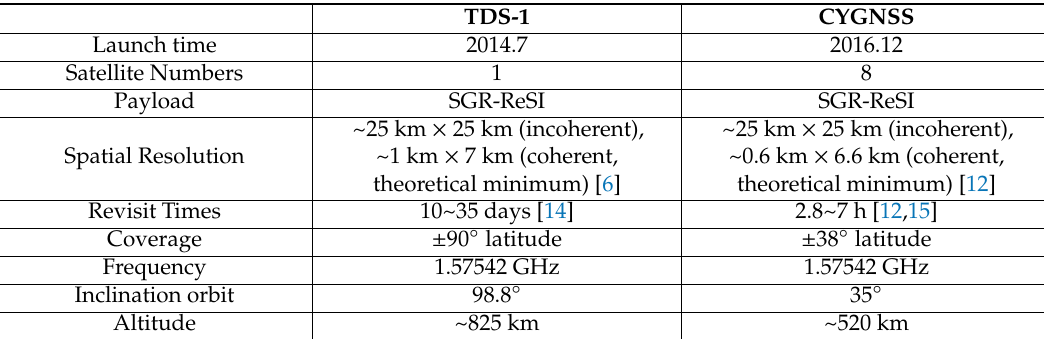
Table 1. General Information of the TechdemoSat-1 (TDS-1) and Cyclone Global Navigation Satellite System (CYGNSS) missions. TDS-1 CYGNSS Launch time